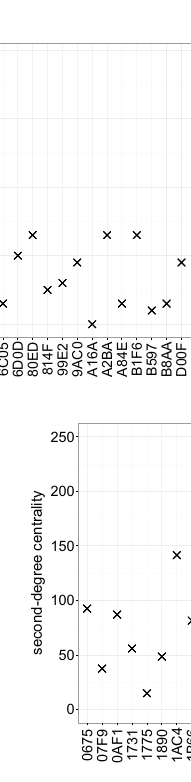
Figure 6. Individual influence quantified according to the three centrality measures introduced in “Social Network Analysis” section: (top left) in-degree centrality, (top right) eigenvector centrality, (bottom) second- degree centrality (top left). For the calculation, the L/F network constructed from the dataset of colony GB2 in year 2008 was used. The x-axis displays the last four digits of a bat’s unique identification